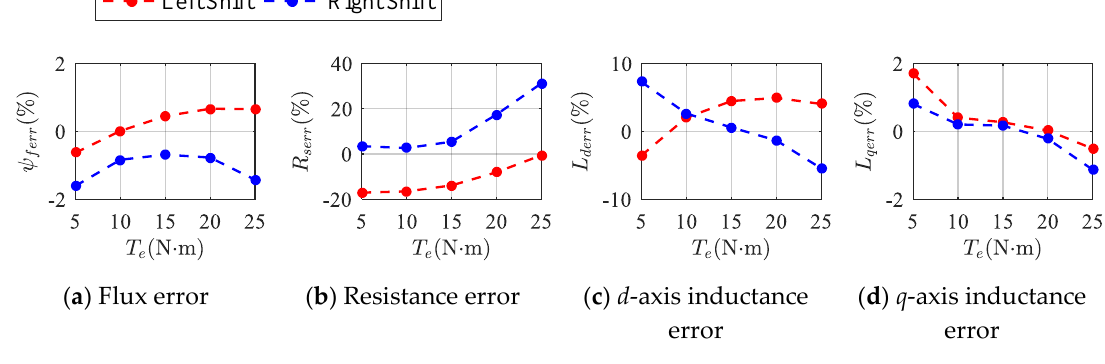
Figure 7. Experimental results.